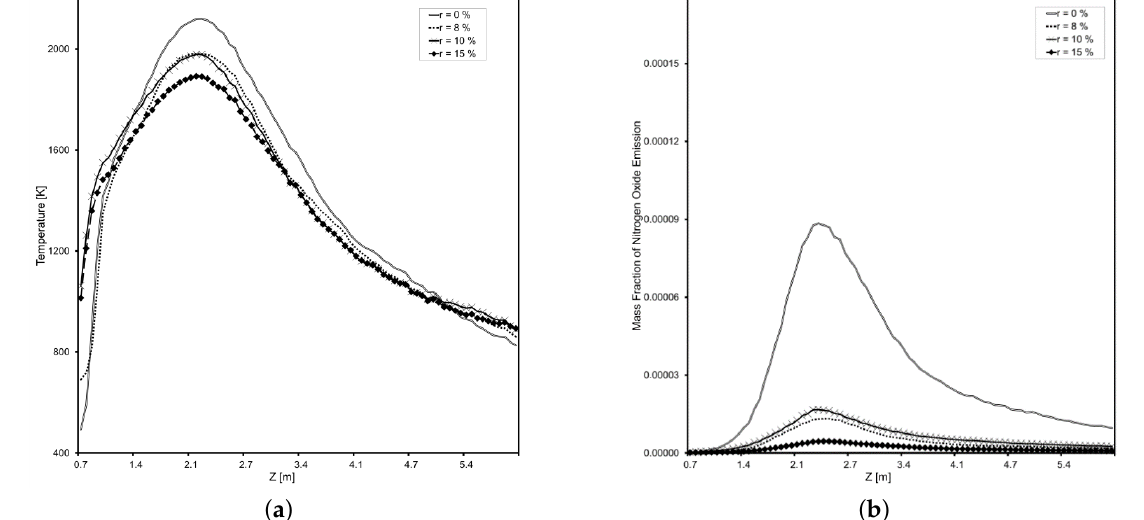
Figure 9. Study of the influence of the degree of recirculation during the combustion of a methane- air mixture of the type of power boiler E-500-13.8-560GMN (steam load of 400 tons per hour): ( a ) temperature comparison; ( b ) comparison of NO X emissions.